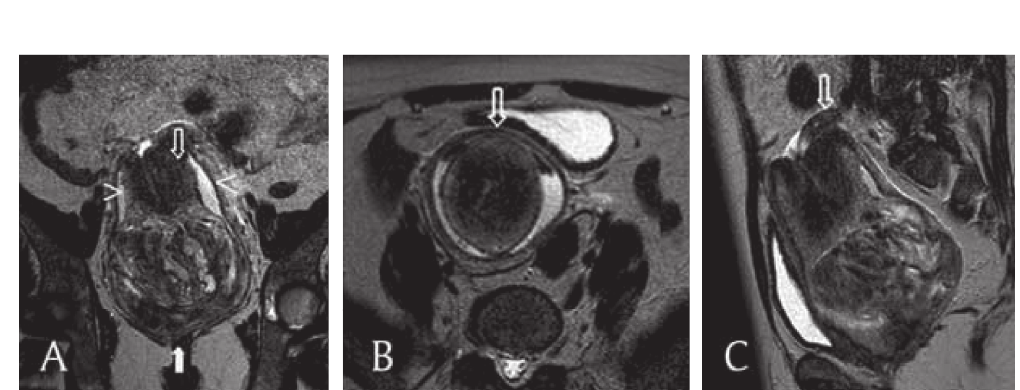
Figure 2: T2-weighted MRI of complete nonpuerperal uterine inversion due to fibroid. (a) This coronal image shows a vaginal het- erogeneous mass (filled arrow), with the uterine corpus in a U-shape above the mass (empty arrow). The cervix surrounds the corpus, and the vaginal fornix surrounds both the corpus and the cervix (arrowheads). (b) This axial image shows, from the center outwards, the uterine corpus, the cervix, and the fornix and the invaginated round ligaments in a bullseye appearance (arrow). (c) This sagittal image shows one ovary above the cervix (arrow) [74].